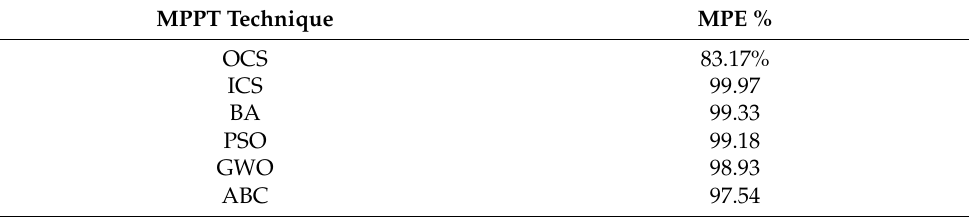
Table 3. The maximum power efficiency for different optimization techniques for 30 s